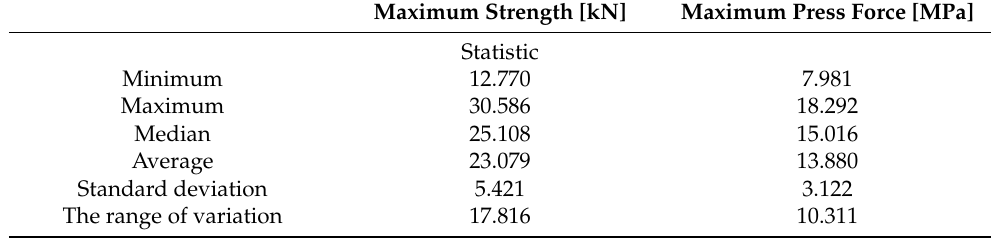
Figure 36. Average values obtained during flexural strength tests after 28 days for water − mix ratio = 0.7, maximal pressure. For water–mix ratio 0.7, flexural strength values once again showed a trend of decreasing strength. For both max. strength and max. pressure, the lowest value was obtained for the mixture with 50% basalt dust. Results were about 49% lower for max. strength and about 48% lower for max. pressure compared to those of the base slurry. For the remaining samples, the reduction in values varied between 0.2% and 40%. Table 22. Compressive strength tests for basalt dust B for all samples for water − mix ratio = 0.7 after 28 days.